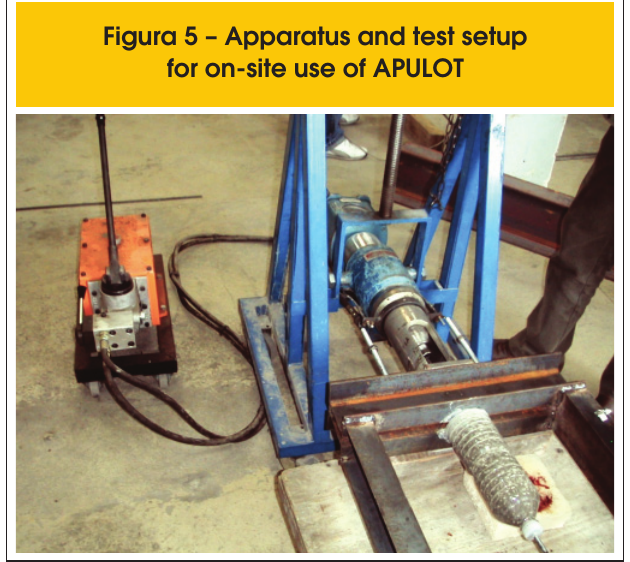
Figura 5 – Apparatus and test setup for on-site use of